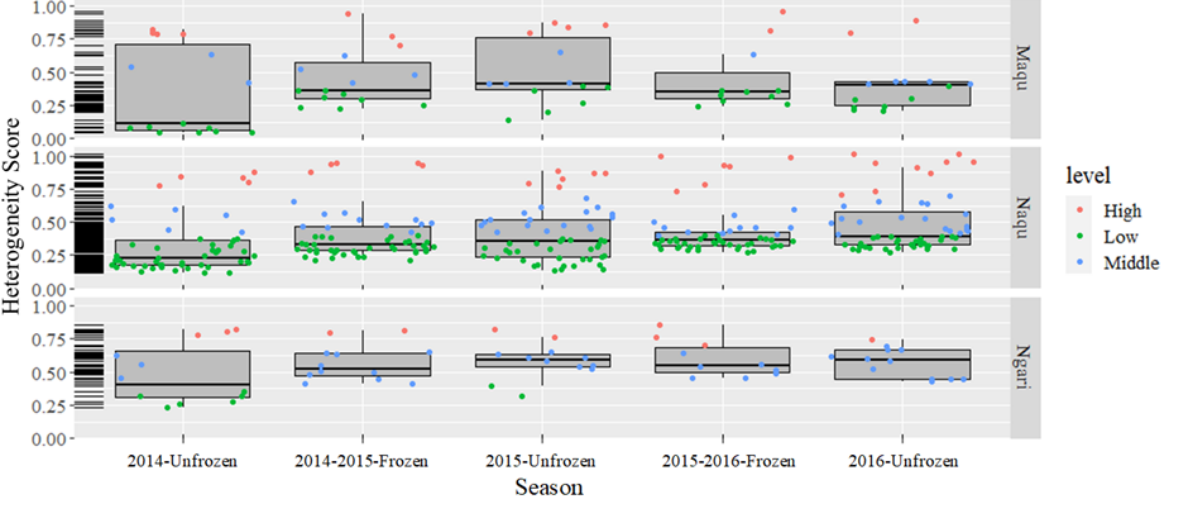
Figure 3. The heterogeneity distributions of all grid cells containing in situ measurement sites within the Naqu, Maqu, and Ngari networks. Green dots indicate low heterogeneity (score ≤ 0.4), blue dots indicate moderate heterogeneity (0.4 < score ≤ 0.7), and red dots indicate high heterogeneity (0.7 < score ≤ 1).